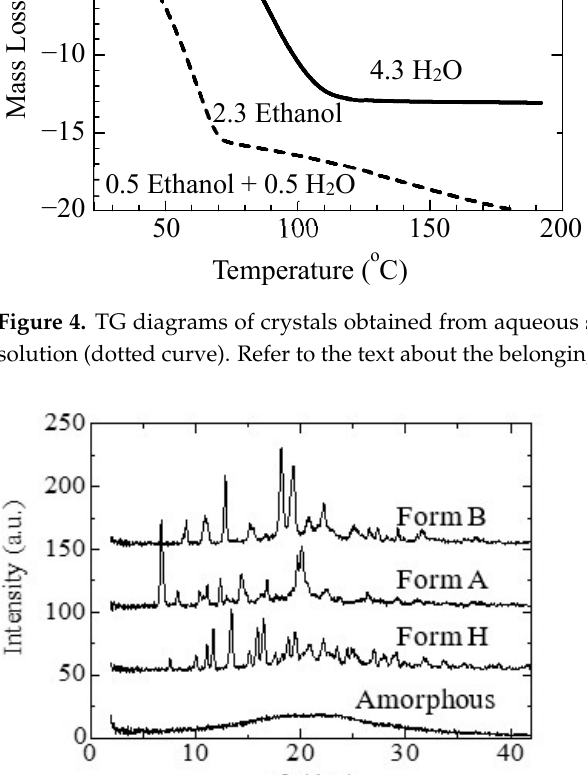
Figure 5. Powder XRD patterns of amorphous CS-023 and three kinds of polymorphs.